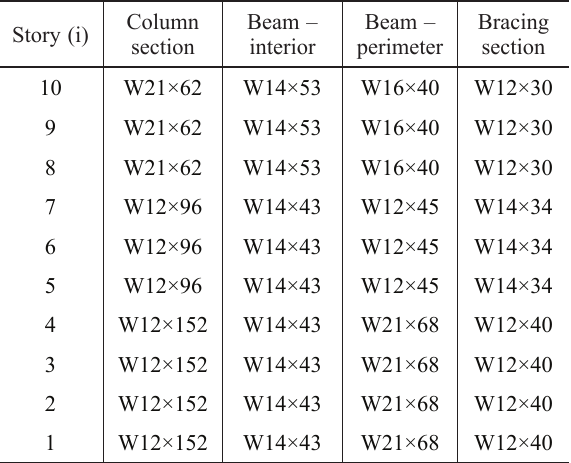
Table 6. Member data for vertically irregular – Eccentrically Braced Frame (EBF) (Young, Adeli 2014a, 2014b) Story